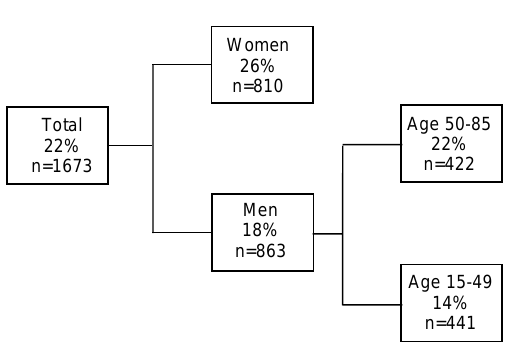
Figure 2. The Pitying Positive (Type